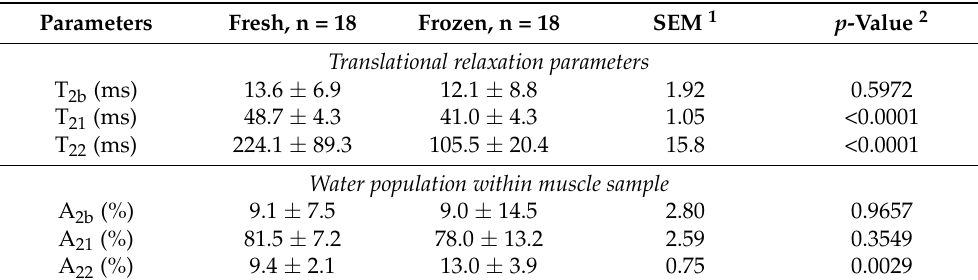
Table 3. Transverse relaxation times (T 2i , i = [b, 1, 2]) and apparent proton populations (A2i,) ob- tained through multi-exponential fitting of the LF-NMR relaxation data for the fresh and frozen lamb meat samples (mean ± standard deviation; n = 18 for fresh, n = 20 for frozen).